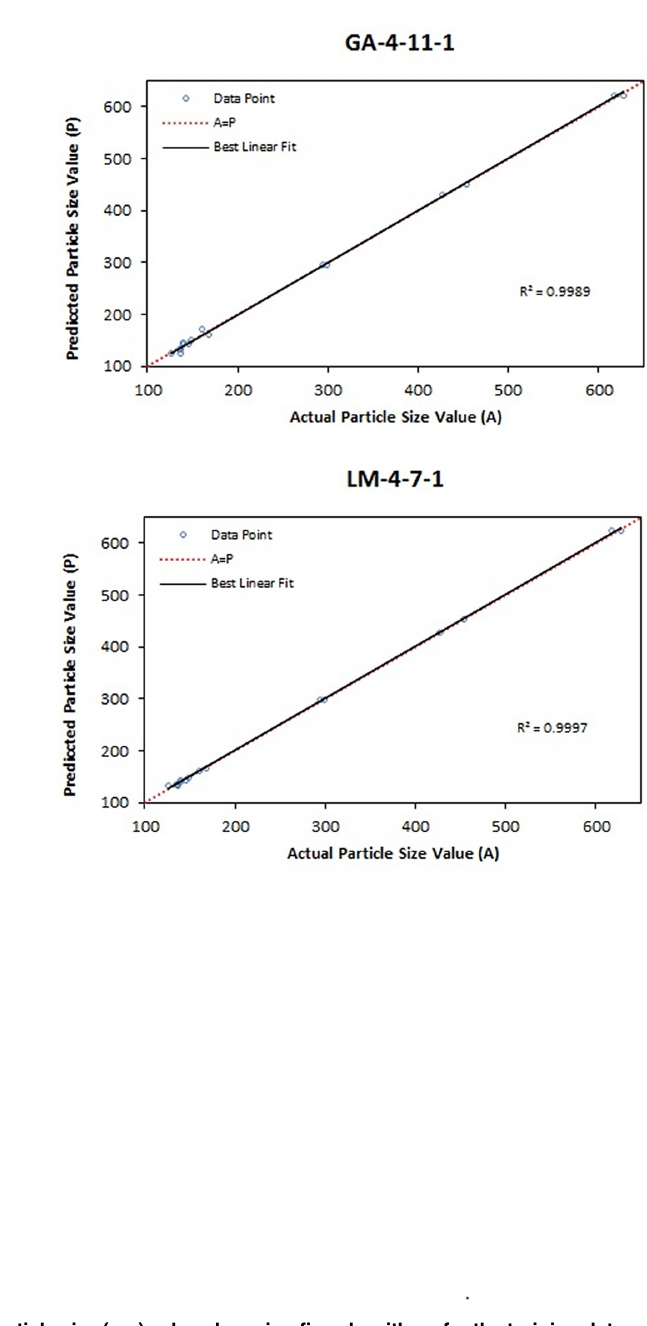
Fig 3. Scatter plot of predicted particle size (nm) values versus actual particle size (nm) values by using five algorithms for the training data set.